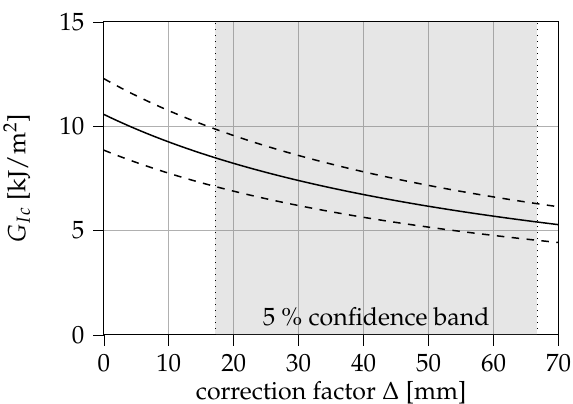
Figure 8. Influence of the correction factor ∆ on the energy release rate (ERR) obtained from modified beam theory.